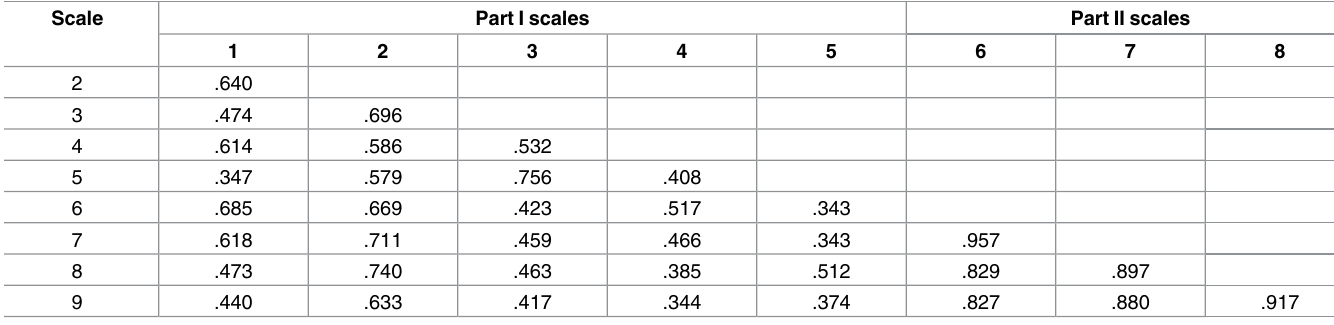
Table 3. Factor correlations of the nine factors of the HLQ-G.